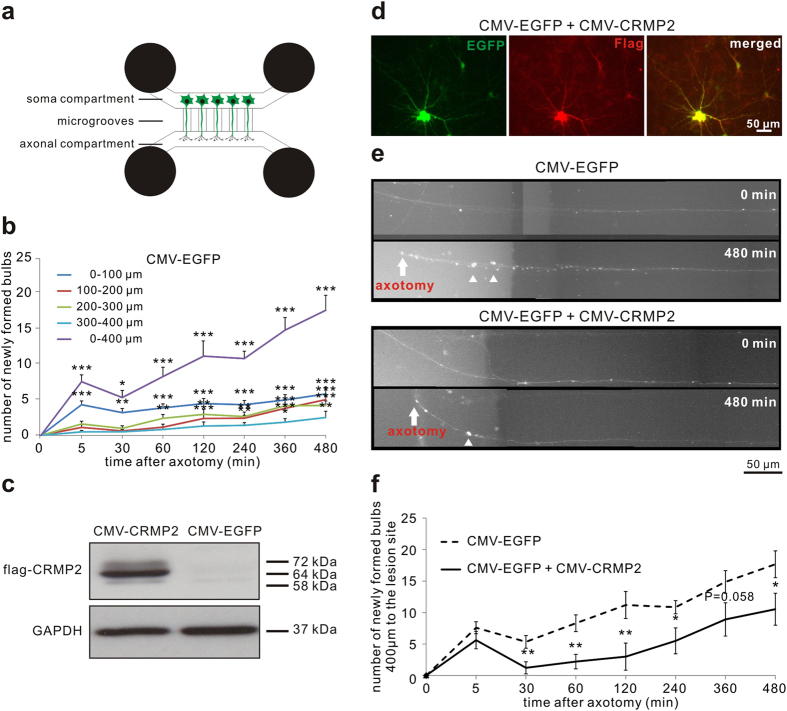
Effects of CRMP2 overexpression on axonal degeneration after axotomy of cortical neurons in vitro.(a) The microfluidic chamber system consists of 4 wells and two channels. The two channels are connected by microgrooves. Rat cortical neurons are plated in the channel named ‘soma compartment’. Only axons can grow across the microgrooves to enter the other channel called ‘axonal compartment’. (b) Quantification of newly formed bulbs in the axons in the given areas proximal to the lesion site at the indicated time points after axotomy after transfection of p.CMV-EGFP. Error bars represent the standard error of the mean (SEM). N ≥ 19 axons. *P < 0.05, **P < 0.01, ***P < 0.001 by one-way ANOVA and Dunnett’s test. (c) Representative Western blot with anti-flag antibody in cortical neurons after transfection with p.CMV-EGFP or p.CMV-CRMP2-flag confirming the overexpression of the CRMP2-flag transcript from the plasmid. (d) Immunostaining with anti-flag antibody confirming co-transfection of p.CMV-CRMP2-flag and p.CMV-EGFP in the cortical neurons. (e) Representative axons proximal to the lesion site at 480 min after axotomy and previous transfection with p.CMV-EGFP as control or co-transfection with p.CMV-CRMP2-flag and p.CMV-EGFP. The number of bulbs was decreased in the axon overexpressing CRMP2 compared to control. (f) Quantification of the number of newly formed axonal bulbs within 400 μm proximal to the lesion site at the indicated time points after axotomy and previous transfection with p.CMV-EGFP or both p.CMV-CRMP2-flag and p.CMV-EGFP. N ≥ 19 axons per group. Error bars represent the standard error of the mean (SEM). *P < 0.05, **P < 0.01 by independent samples t-test.